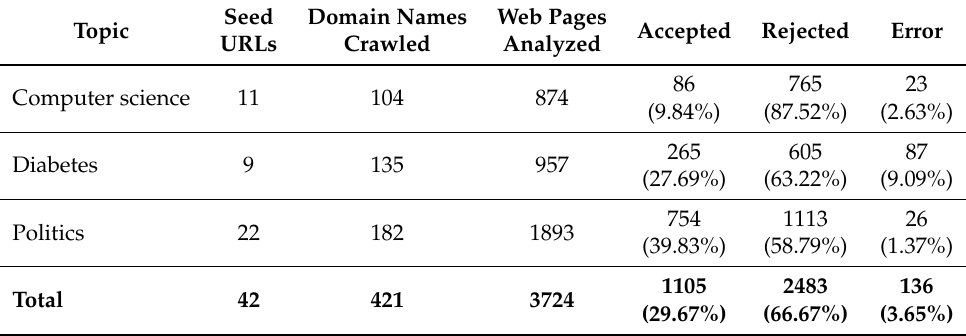
Table 6. Google results for crawled seed URLs.